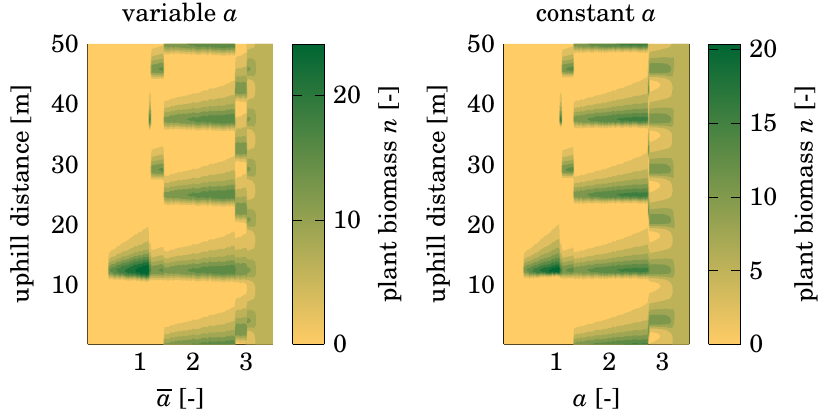
Figure 4. Results of the one-dimensional Klausmeier model after 1500 time-steps are shown for variable and constant precipitation. Resulting biomass peaks are shown for different values of mean precipitation. The maximum of plant biomass is located at 12.5 m uphill distance for each run. Random initial conditions have been used. Initial conditions have been the same for every value of a .